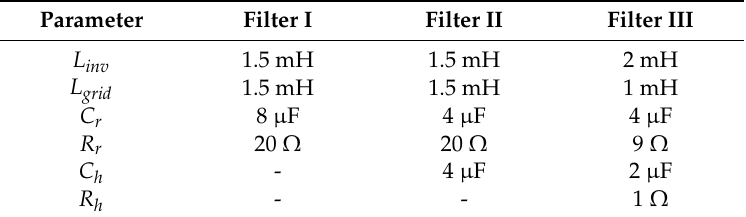
Table 2. Filter Design Parameters.